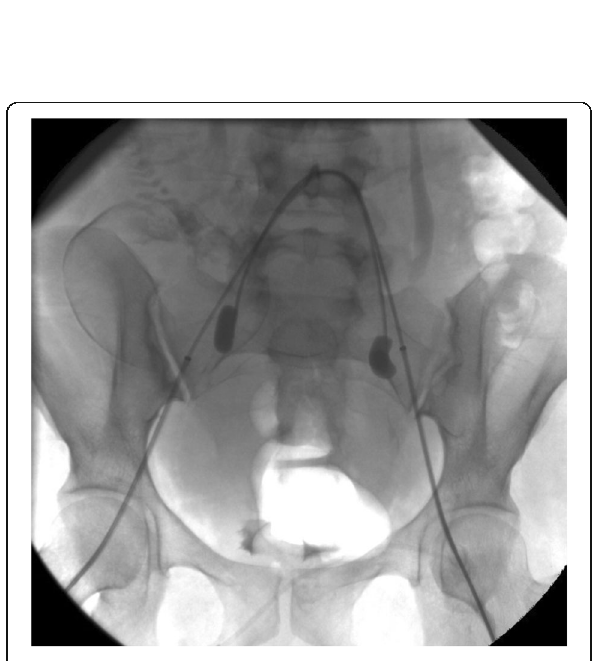
Fig. 5 Fluoroscopic spot image demonstrates bilateral common femoral arterial access with 6 french sheath with internal iliac artery balloon placement. Note the fetus is visualized within the pelvis